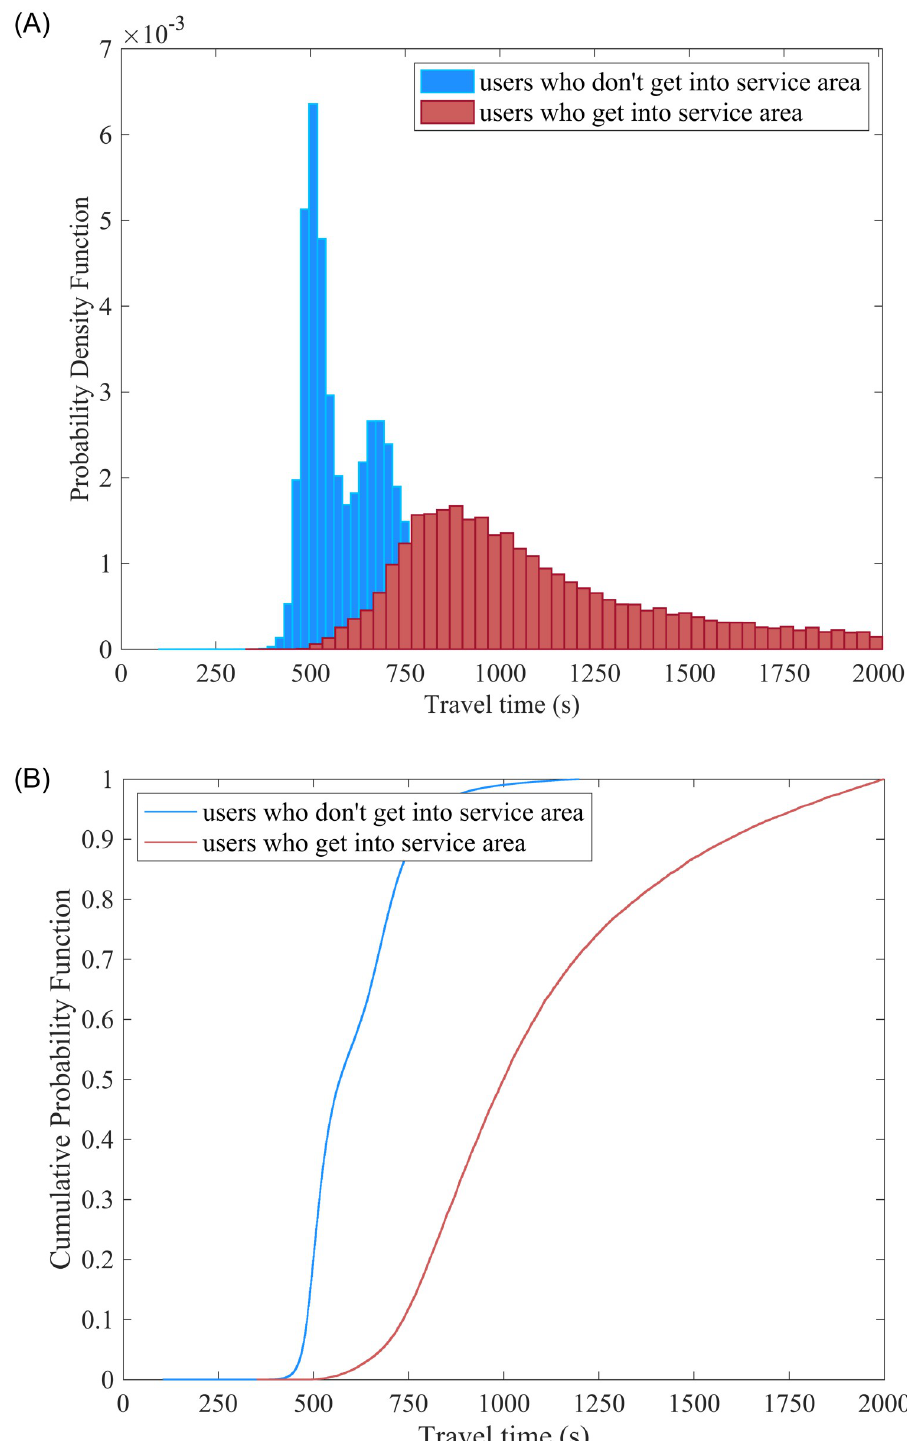
Fig 8. PDF curves and CDF curves. A: PDF of travel time. B: CDF curves of travel time.